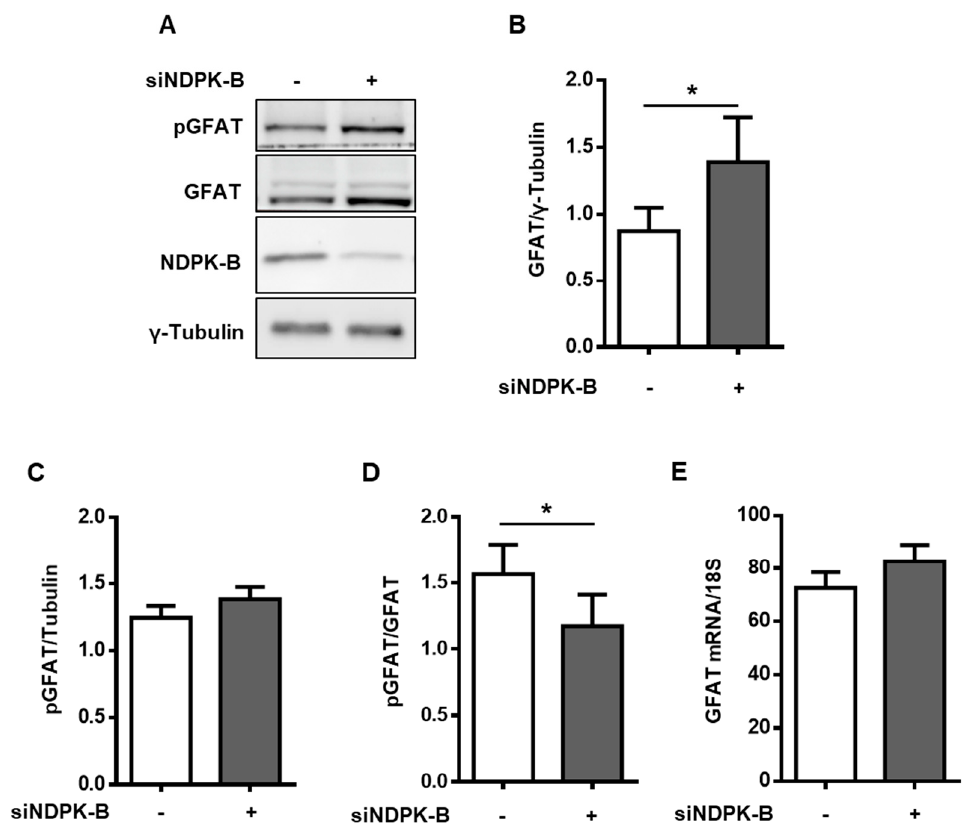
Figure 3. Loss of NDPK-B in ECs increases GFAT content and activity. ( A ) HUVECs transfected with either scrambled control ( − ) or siRNA against NDPK-B (siNDPK-B, +) were analyzed for NDPK-B, GFAT, and GFAT phosphorylated at Ser243 (pGFAT) content by immunoblotting. ( B ) Quantification of the GFAT content relative to loading control, γ -tubulin. ( C ) Quantification of pGFAT content relative to loading control, γ -tubulin. ( D ) Quantification of pGFAT / GFAT. ( E ) qPCR quantification of GFAT mRNA expression relative to 18S. GFAT: glutamine:fructose-6-phosphate amidotransferase. Results are presented as mean ± SD from n = 5 independent experiments. *: p < 0.05.